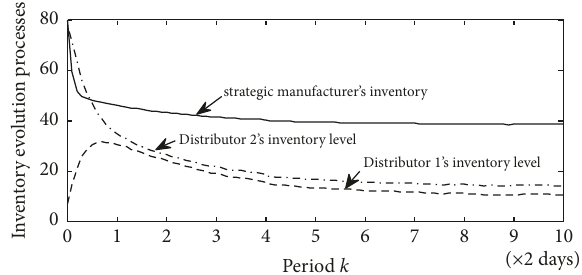
Figure 3: Evolution processesof statevariables underthe firstinitial inventory statuses ( ×10 5